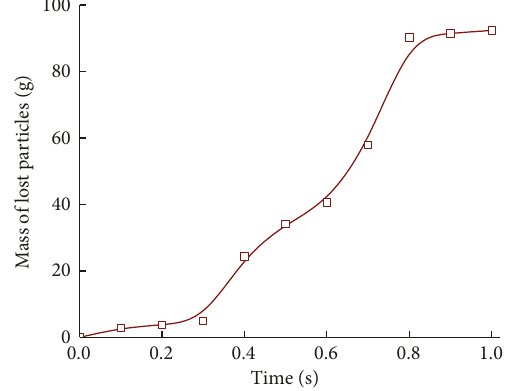
Figure 9: Variation curve of lost particle mass with